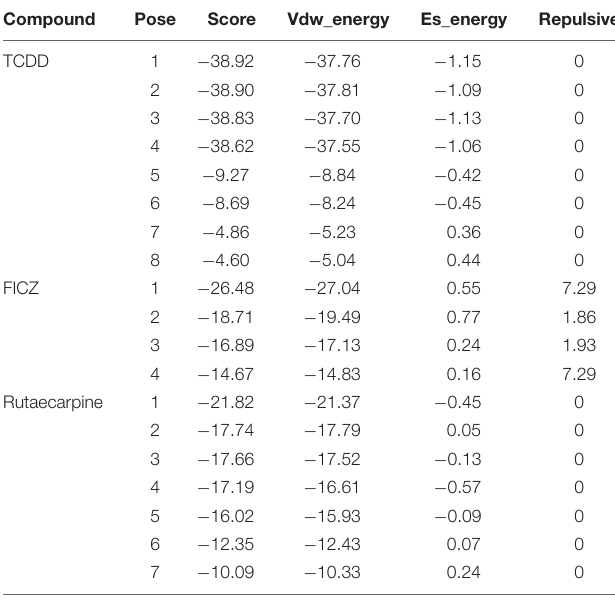
TABLE 3 | Binding energy (kcal/mol) and molecular docking scoring of the AhR with target chemicals. Compound